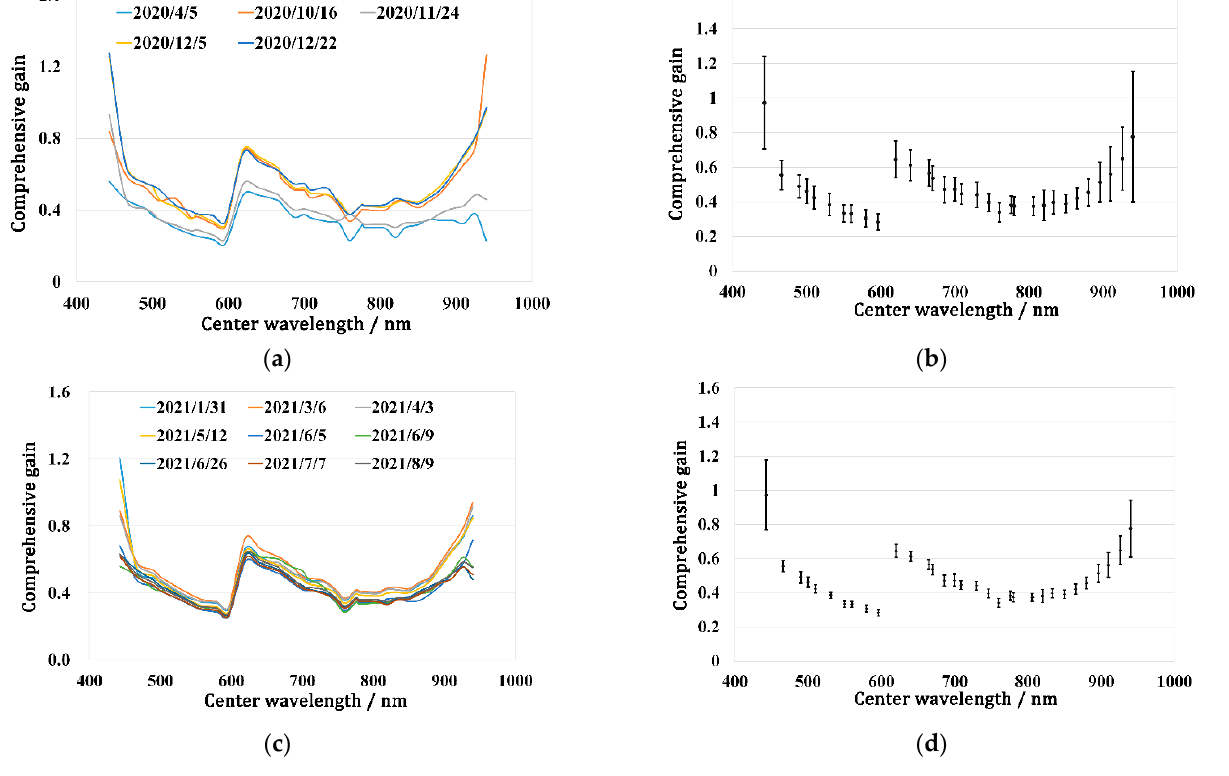
Figure 10. Calibration results for OHS-F CMOS2. ( a ) Description of comprehensive gains in 2020; ( b ) description of averaged value and SD of comprehensive gains in 2020; ( c ) description of comprehensive gains in 2021; ( d ) description of averaged value and SD of comprehensive gains in 2021.